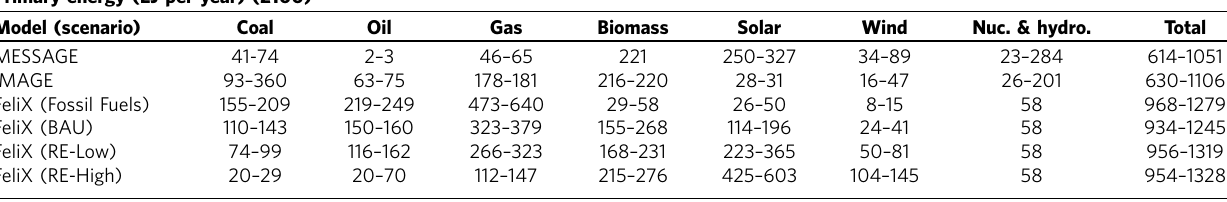
Table 2 | Primary energy consumption in year 2100 of FeliX and similar models.